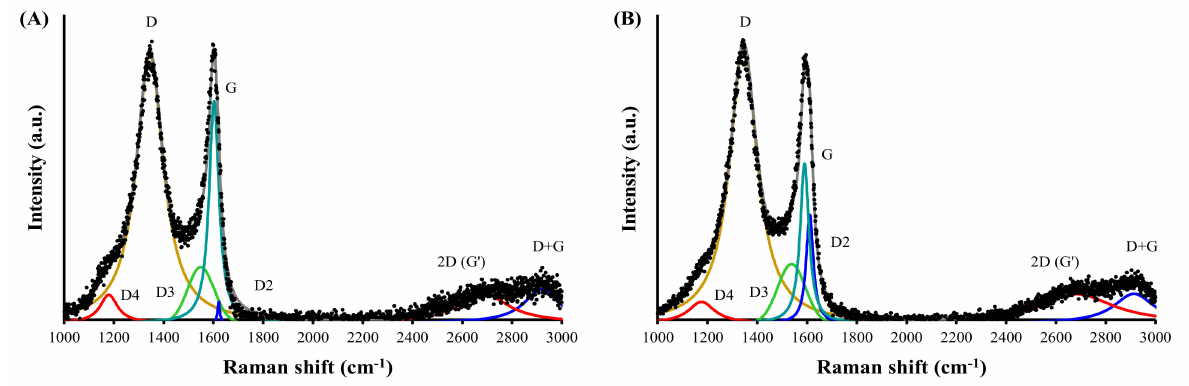
Figure 2. Raman spectra of ( A ) PAC and ( B )